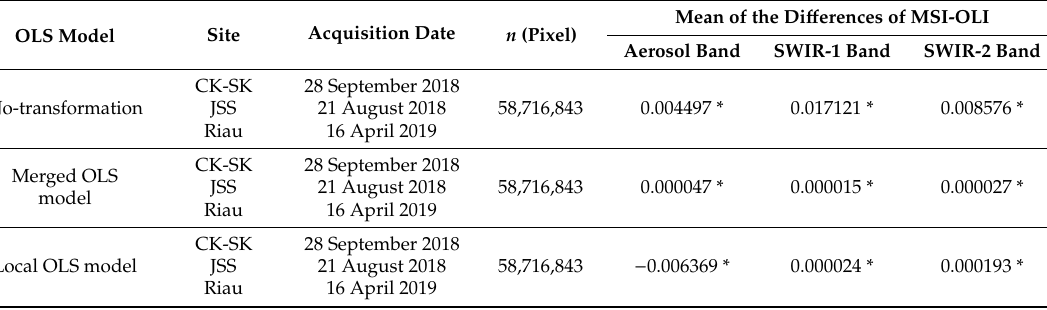
Table 6. The mean di ff erences of TOA reflectance of Sentinel-2 Multi Spectral Imager (MSI) and Landsat-8 OLI at aerosol, SWIR-1, and SWIR-2 bands. Total data ( n ) were compiled from three data sets representing study sites in Central Kalimantan and South Kalimantan (CK-SK), Jambi and South Sumatera (JSS), and Riau. * Resulted from t -test with significant di ff erent at p -values <